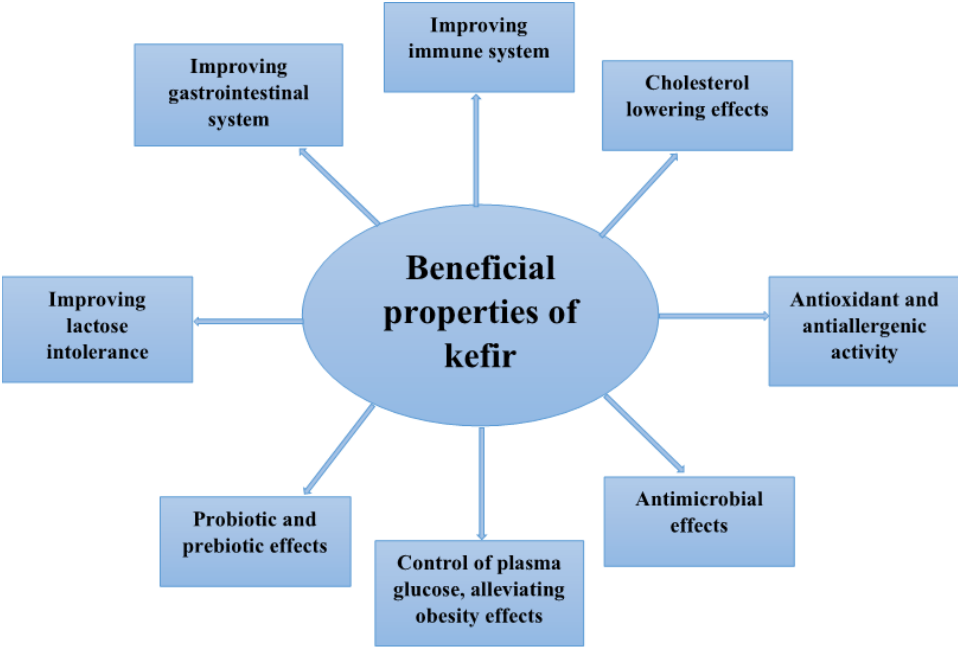
Figure 3. Recapitulated beneficial properties of kefir.